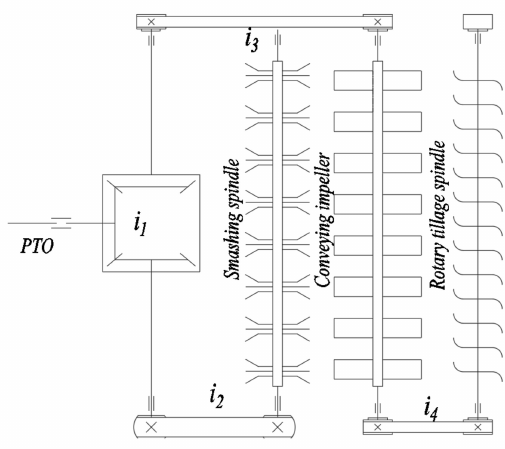
Figure 3. Schematic diagram of transmission